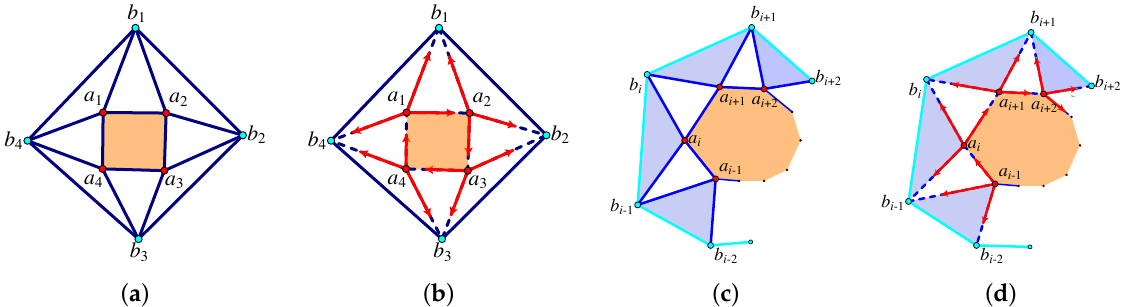
Figure 69. A C 1 -cofactor graph with free vertices (analogues of pinned vertices in frameworks) shown in turquoise ( a ) and 2 with a 3-directed covering ( b ). Figure ( c ) is a more general example with ( d ) showing a 3-directed covering for computing the pure conditions for singularity. The larger interior polygons will be single polynomials in the